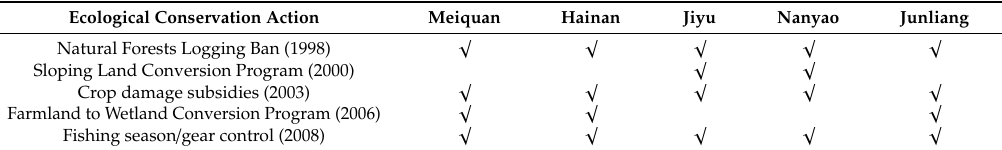
Table 1. Ecological conservation actions carried out in villages in the Lashihai